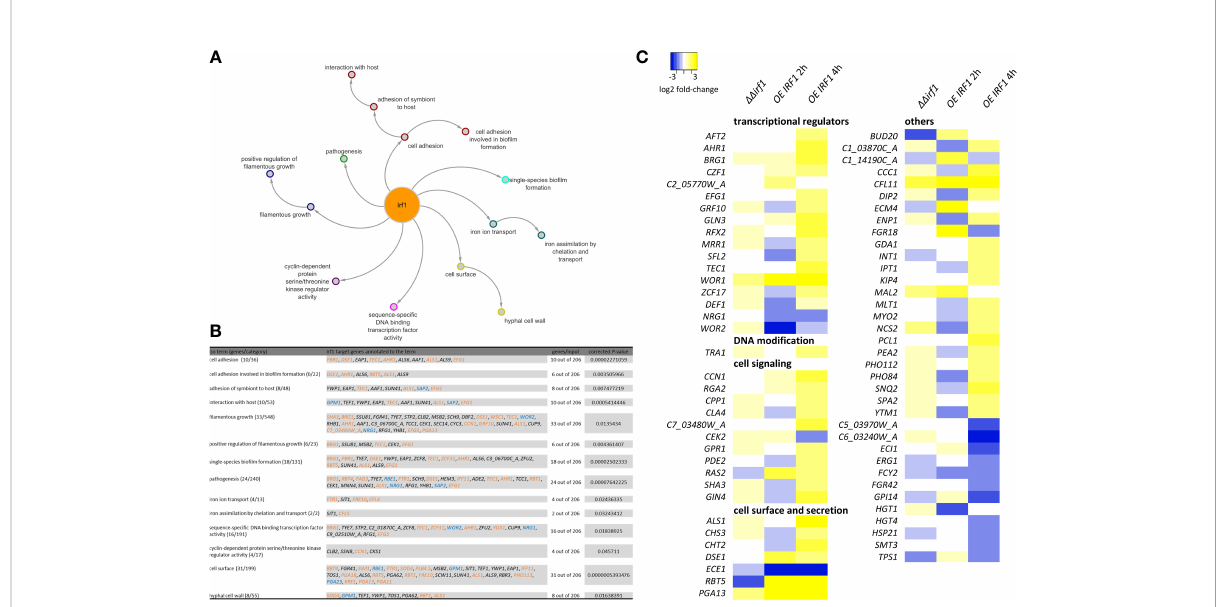
FIGURE 3 Functional analysis of Irf1 target-genes. Gene-ontology analysis was used to functionally classify identi fi ed target genes. The corresponding GO categories are presented (A) as a network with corresponding subcategories and (B) summarised in a table. For this analysis, only genes that could be identi fi ed by ChIP-Seq (direct target-genes) were considered. Genes whose names are highlighted also show a signi fi cant difference in expression when IRF1 is overexpressed (blue = down, orange = up, black = no signi fi cant change). (C) Heatmap of expression differences (log2 fold-changes) of identi fi ed genes assigned to the GO category fi lamentous growth. The analysis also included genes that did not have a direct binding site of Irf1, but whose expression was altered by the overexpression of IRF1 or by deletion, in the irf1 mutant